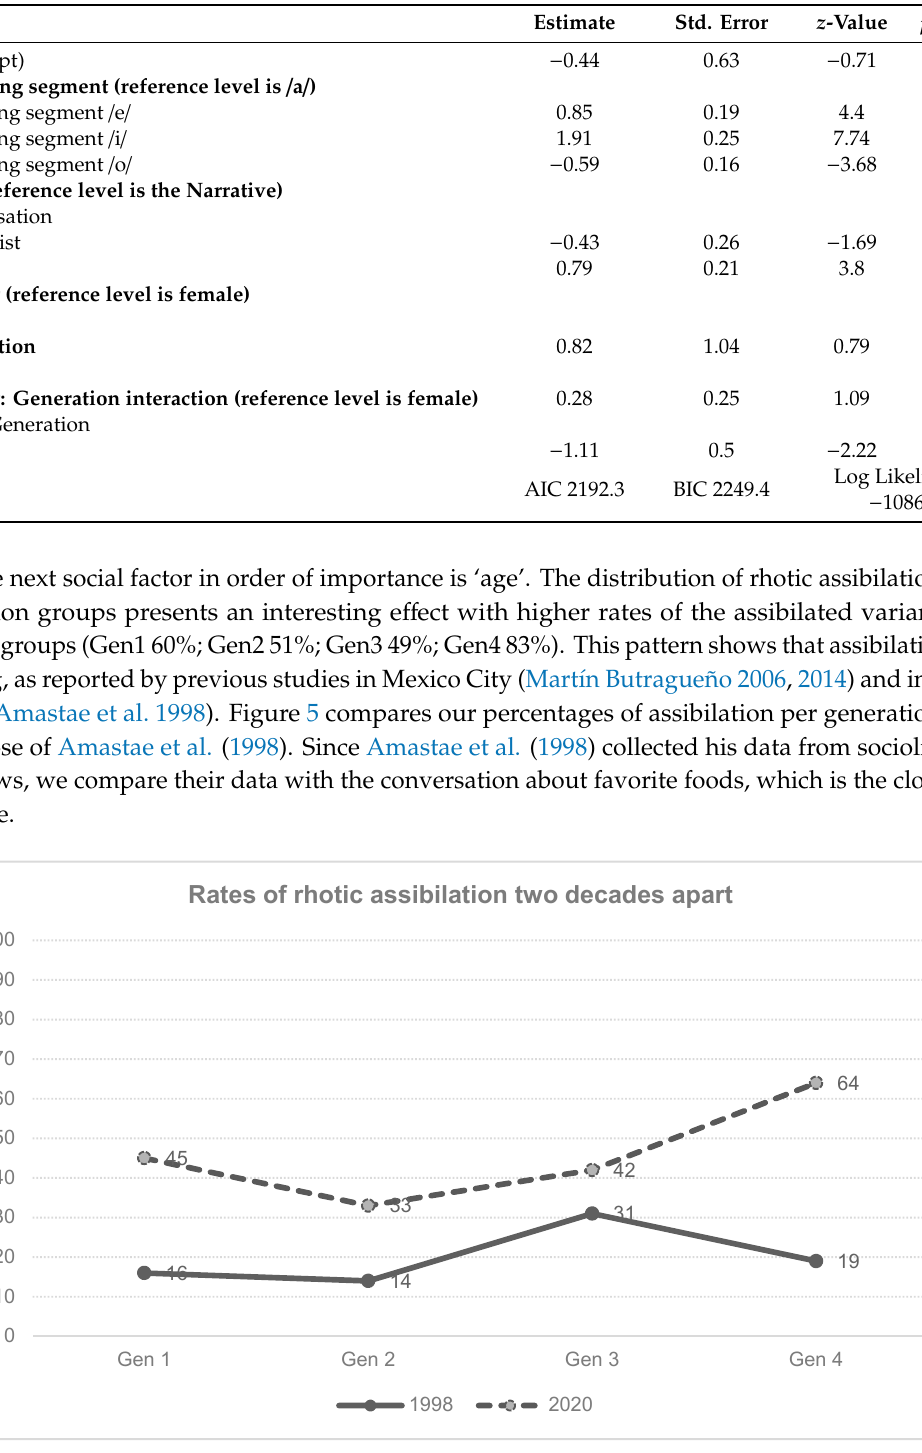
Table 4. Binary logistic regression model coe ffi cients with previous segment, task, and gender as predictors.